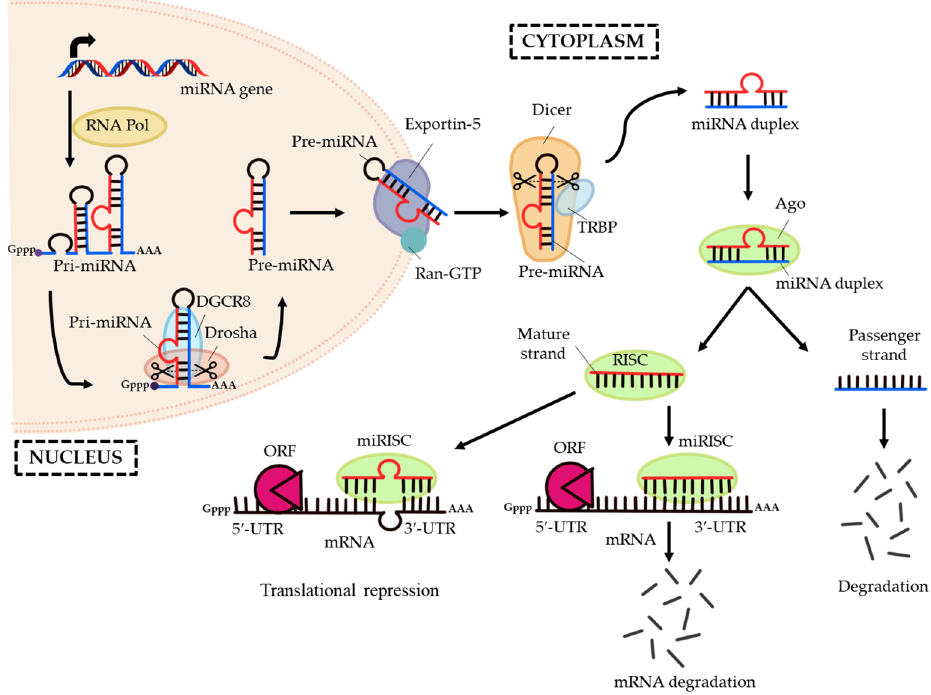
Figure 1. The pathway of microRNA biogenesis and gene silencing.